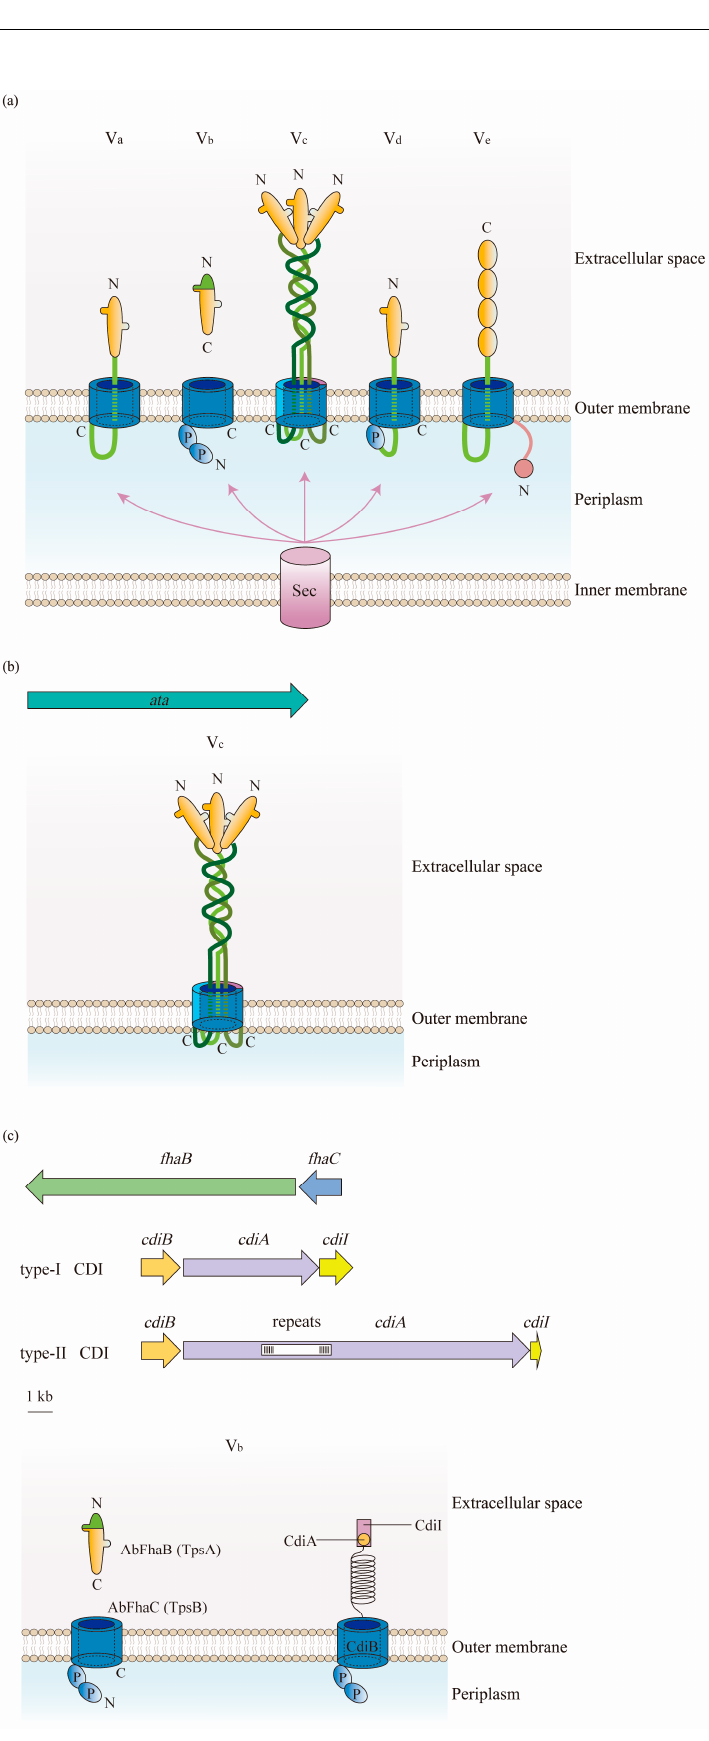
Figure 4. Structure of the type V secretion system (T5SS) in A. baumannii : ( a ) There are five types of T5SS in Gram-negative bacteria. They consist of three parts: a signal sequence at the N-terminus, a secreted passenger in the extracellular milieu, and a transporter at the C-terminal. β -Barrels are